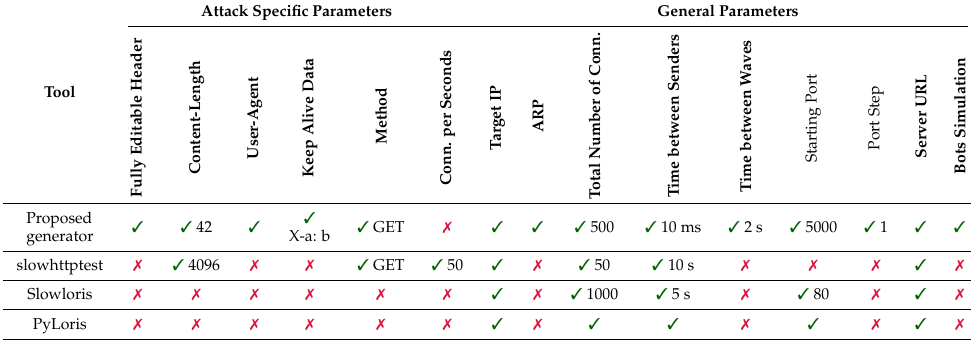
Table 3. Comparison of the proposed generator from the Slowloris attack point of view. Attack Specific Parameters General Parameters